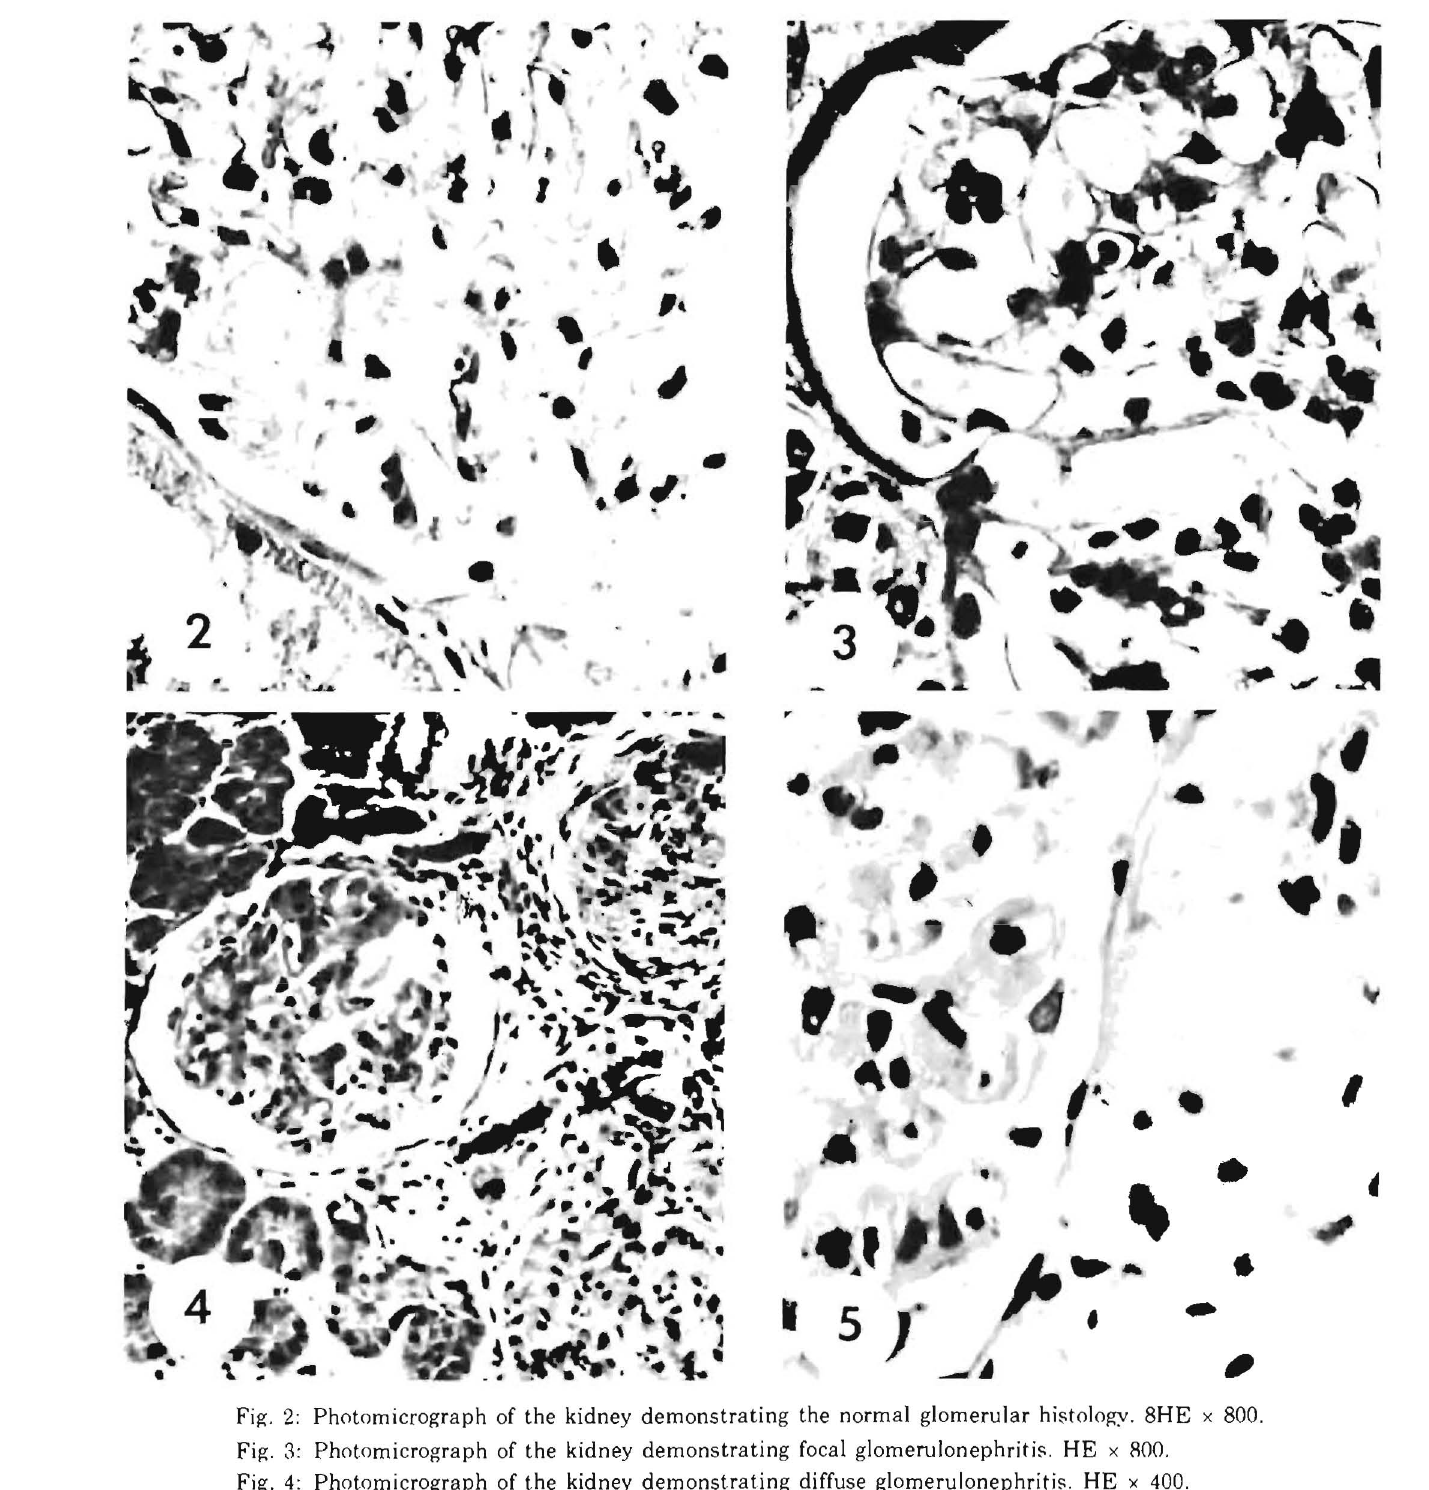
culating T and B lymphocytes and increased numbers oflymphocytes that lack either B or T markers ("N ull Cells")S JS